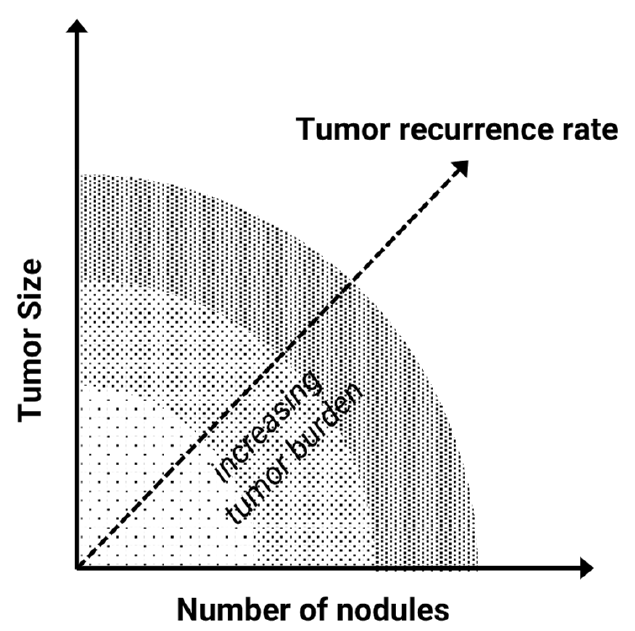
Figure 1. Traditional concept of selection criteria for transplant candidates by tumor burden as defined by number of nodules and tumor size (e.g., Milan criteria ). Theoretically, according to this model, the tumor recurrence risk should incrementally increase according to the area under the curve representative for total hepatic tumor burden.